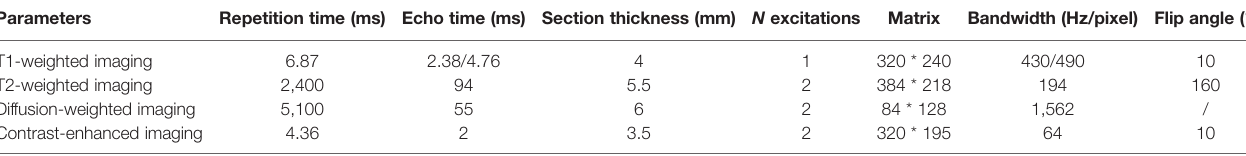
TABLE 1 | MRI sequences and